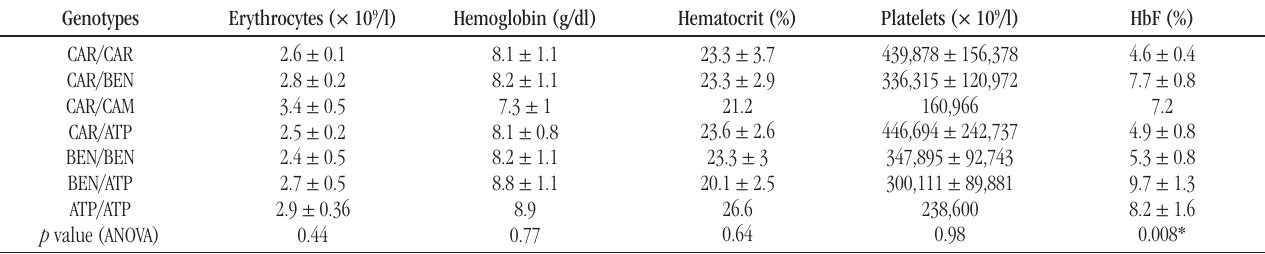
taBLE 3 − Hematologic characteristics in association with genotype